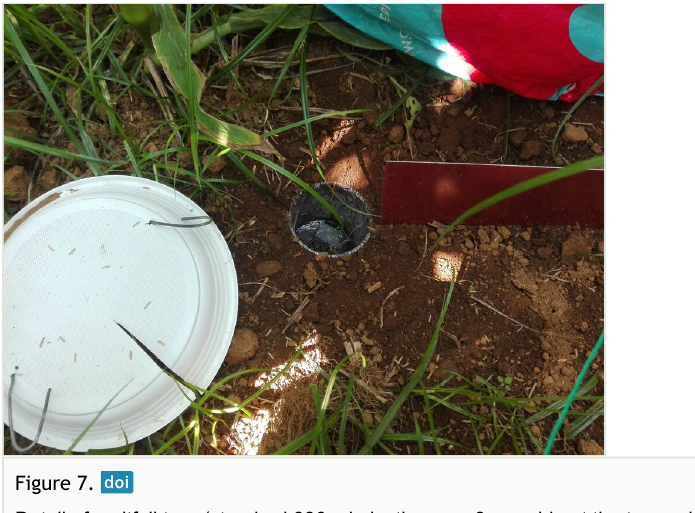
Detail of a pitfall trap (standard 330 ml plastic cups, 8 cm wide at the top and approximately 12 cm deep) (Credit: Rui